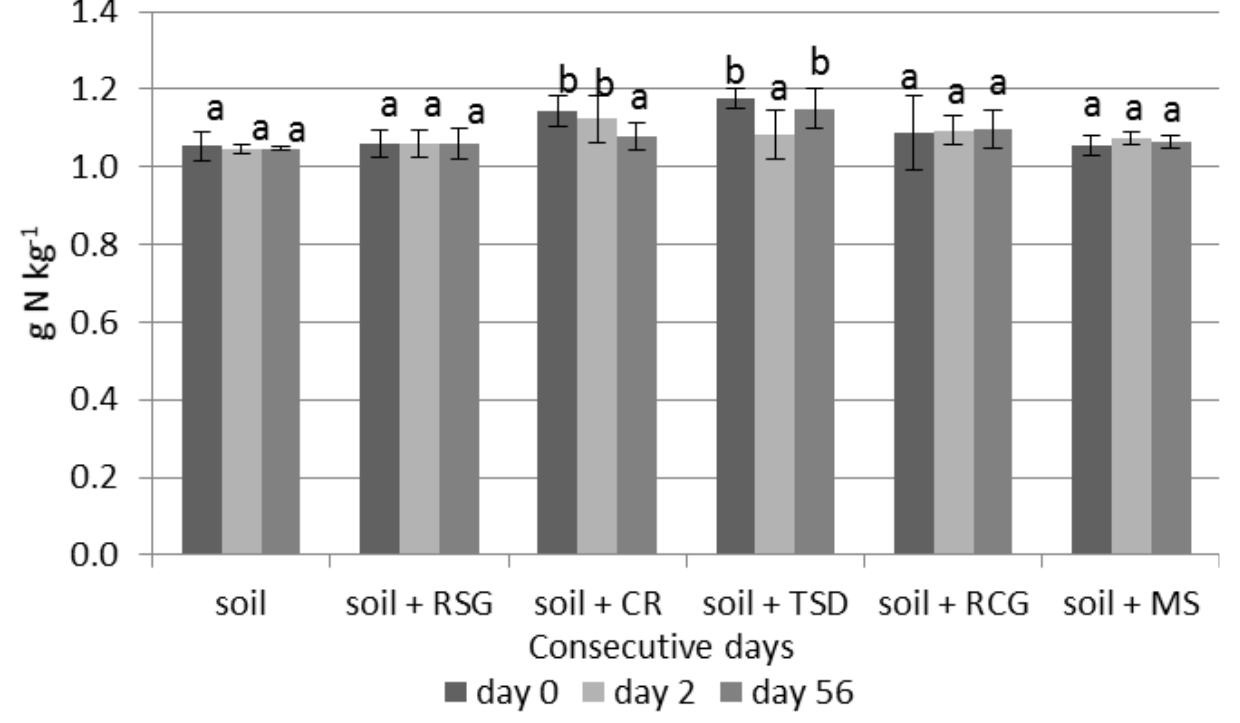
Figure 2. TKN content (mean value ± standard deviation) in the control (soil) and in soils treated with reed sweet-grass digestate (RSG), common reed digestate (CR), tufted sedge digestate (TSD), reed canary grass digestate (RCG) and maize digestate (MS). Different letters indicate significant differences at Days 0, 2 and 56 (p < 0.05) according to Tukey’s